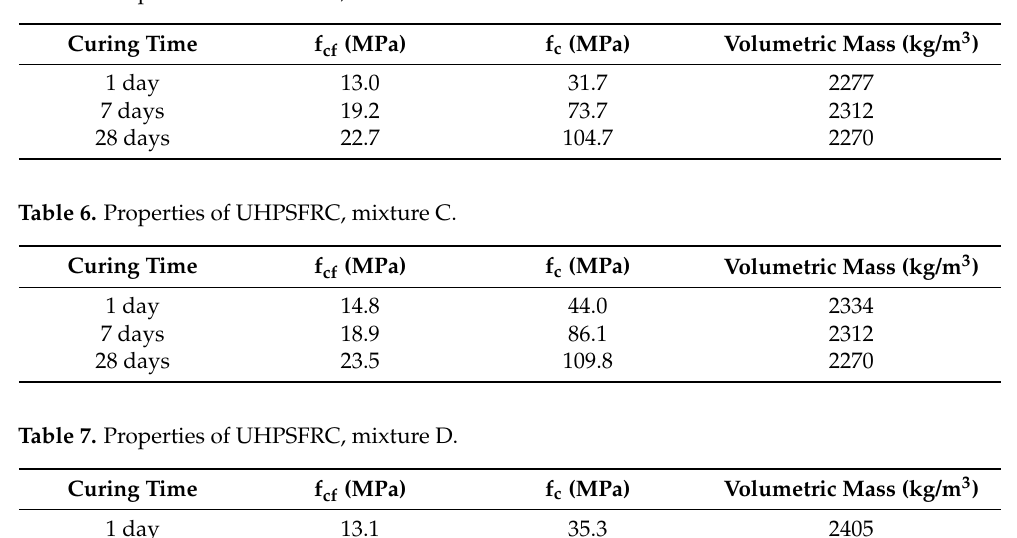
Table 5. Properties of UHPSFRC, mixture B.